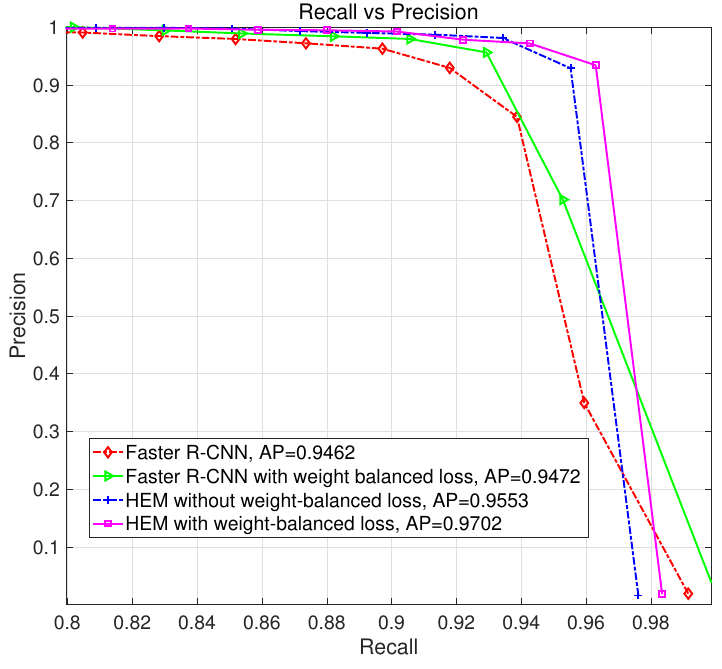
Figure 7. Comparison of HEM and new loss